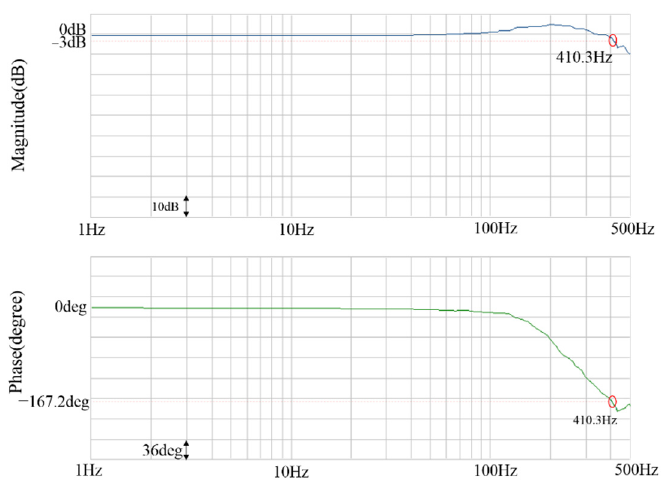
Figure 15. Bode plots of q -axis current control loop using PI-type SMC at 1000 rpm with 4.75 Nm.